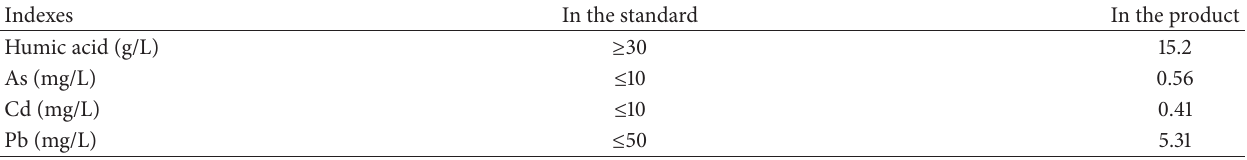
Table 3: The contents of humic acid and heavy metals in the product and the comparison with the standard.